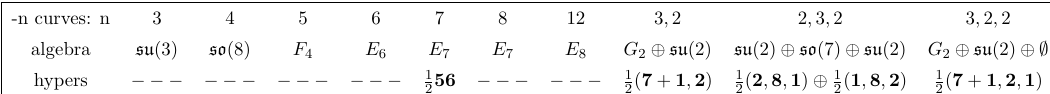
Table 1 . All possible non-Higgsible clusters with minus the self-intersection numbers n of curves, the symmetry algebras of the minimal singularities of elliptic fibers, and possible charged